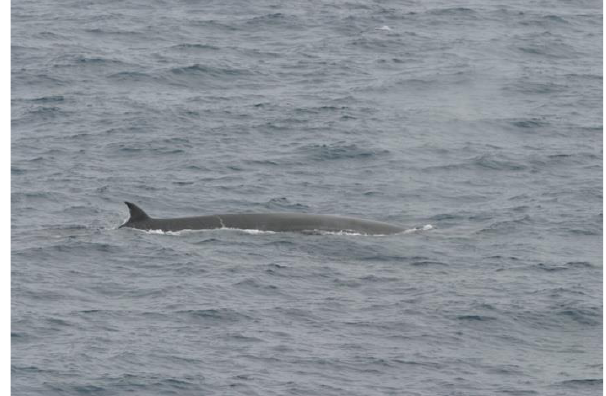
Figure 1. Sei whale in the Irminger Sea observed during the Trans-North Atlantic Sightings Survey in July